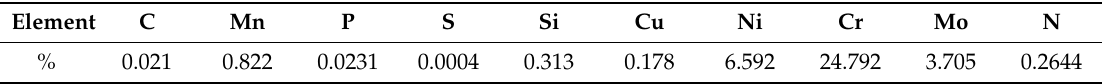
Table 1. Chemical composition of UNS